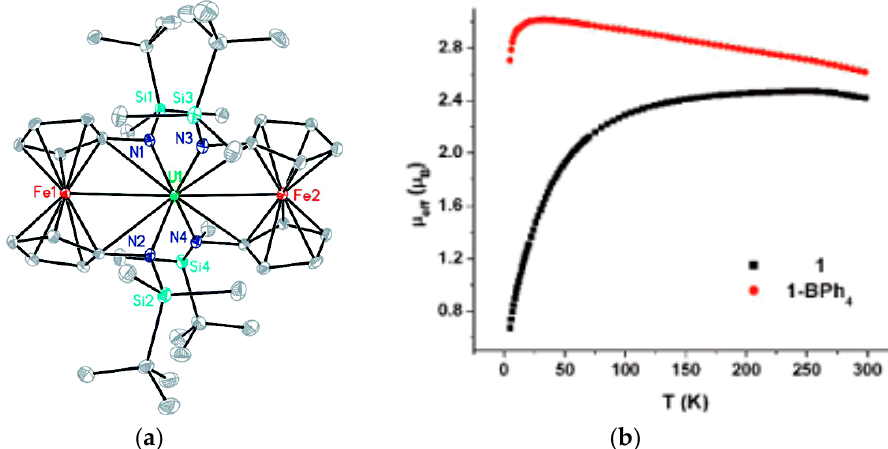
Figure 32. ( a ) X-ray Structure of [Fe II U IV Fe III (C 5 H 4 NSi( t Bu)Me 2 ) 4 ] cation (1 + ) complex. H atoms are omitted for clarity. ( b ) Variable-temperature magnetic data for UFe II2 (1, black squares) and Fe II U IV Fe III (1-BPh 4 , red circles). (Reprinted with permission from [18], American Chemical Society, 2007).